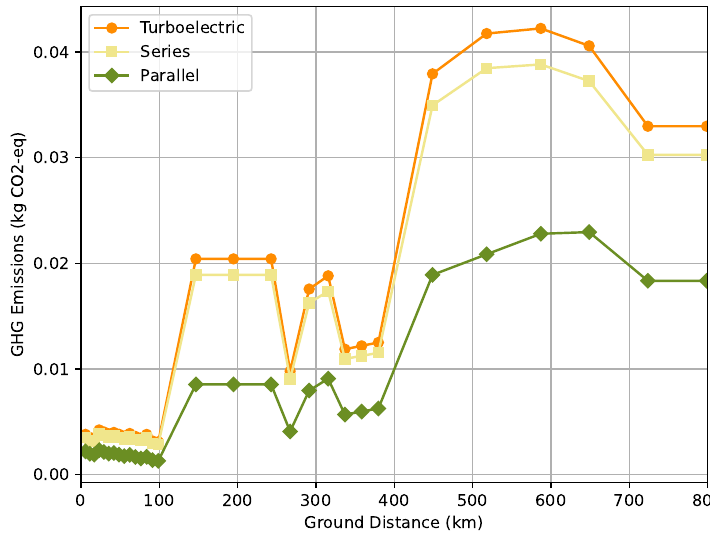
Figure 14. Comparison of the emissions between the three